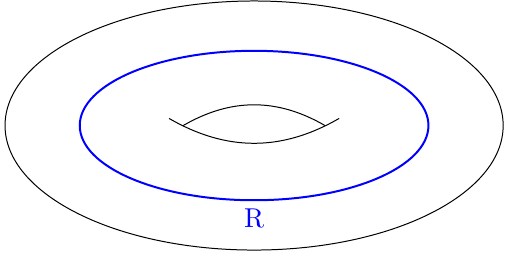
Figure 25 . Solid torus with a Wilson loop operator inserted.